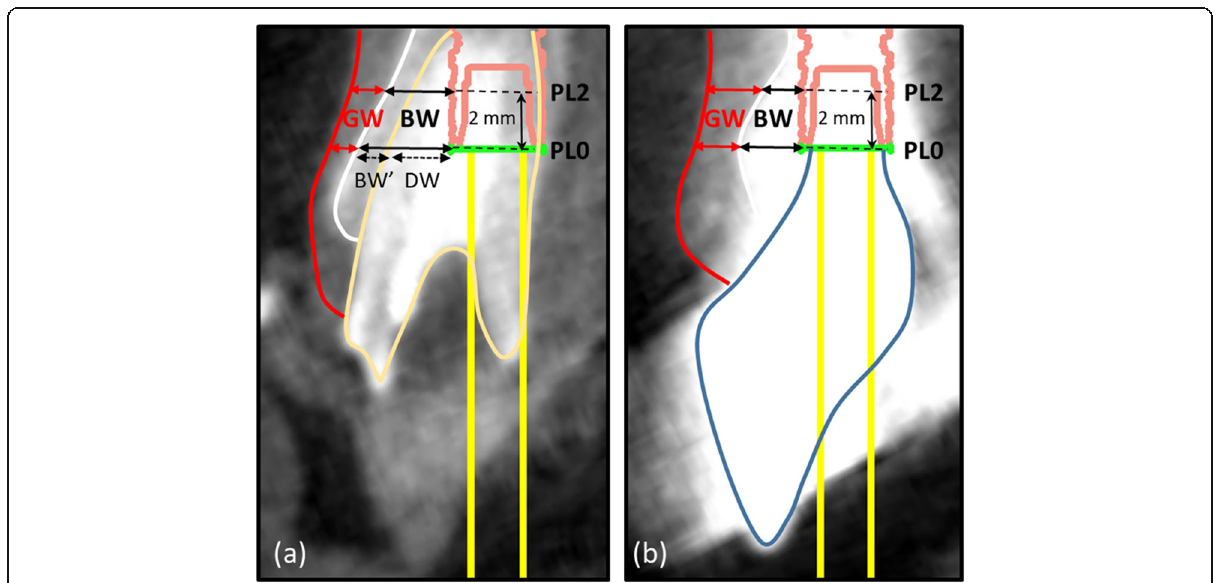
Fig. 3 Measurement on buccopalatal cross-sectional images preoperatively and 1 year after connection of the definitive prosthesis. a Virtual implant models were used as the measurement reference preoperatively. The horizontal distance from the implant surface to the facial bone surface (BW) and the horizontal width of the soft tissue (GW) were measured at the implant platform level (PL0) and 2 mm apical to the implant platform (PL2). The implant-socket gap (the distance from the virtual implant surface to the root surface) (DW) and the horizontal width of the facial alveolar bone (BW ’ ) were measured at PL0. b The horizontal width of bone (BW) and soft tissue (GW) were measured at PL0 and PL2 1 year after connection of the definitive prosthesis